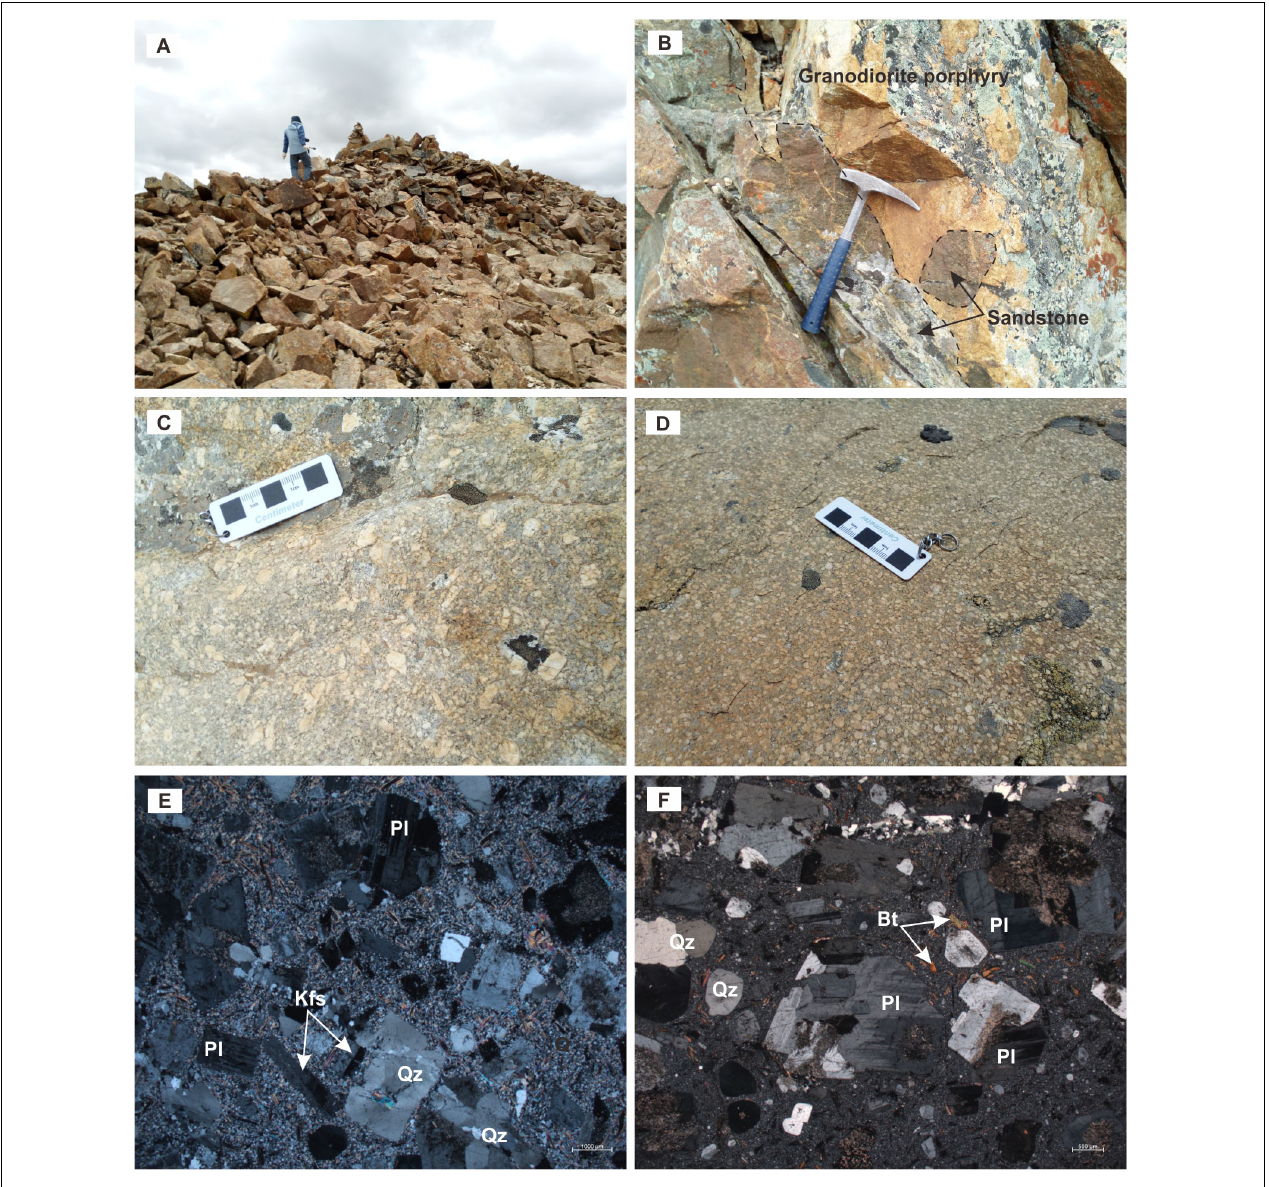
FIGURE 2 | Field pictures and micrographs for Haweng granodiorite porphyries. (A,C,E) Are for sample 17JT15, whereas (B,D,F) are for sample 17JT13. Abbreviations: Bt, biotite; Kfs, K-feldspar; Pl, plagioclase; Qz, quartz.